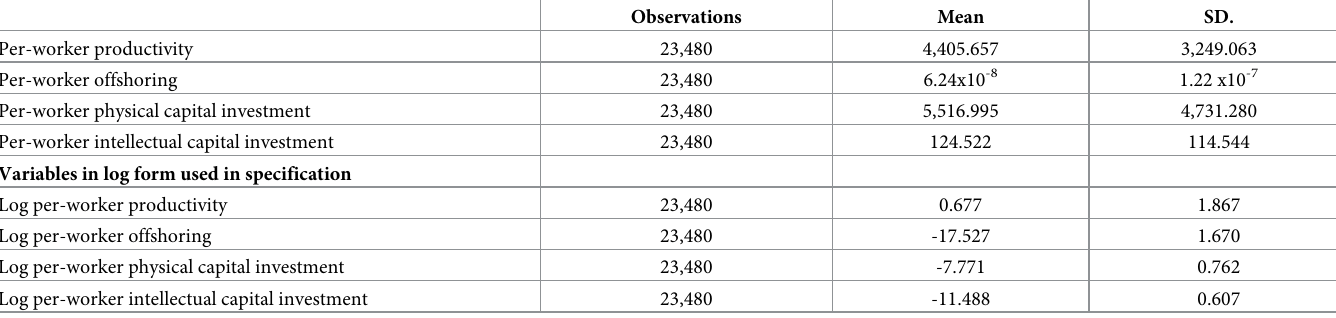
Table 1. Summary statistics of selected